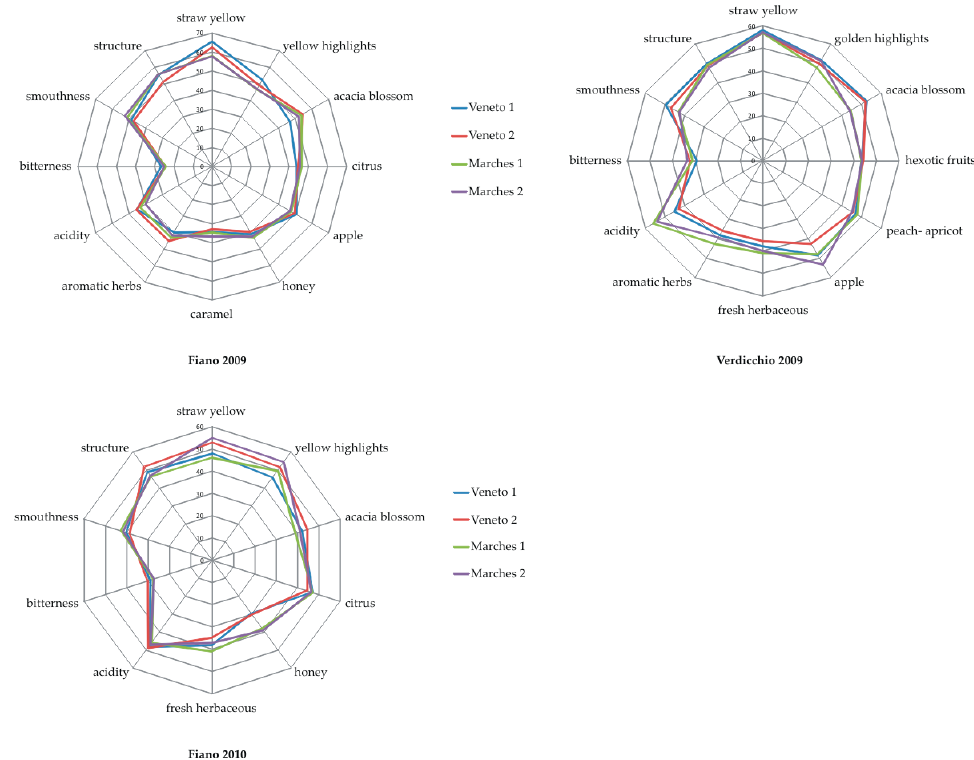
Figure 1. Sensory profiles of white wines.